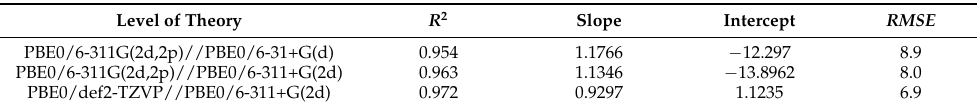
Table 2. Empirical scaling factors obtained by the linear regression analysis of calculated and experimental δ 31 P for the title Pd complexes.